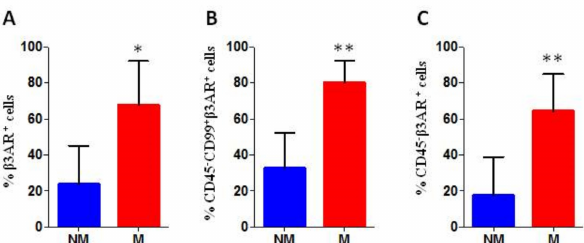
Figure 5. Cytofluorimetric analysis of biopsies derived cells, the percentage of positive cells is reported. ( A ) percentage of β 3-AR positive cells within all cells derived from the biopsy (% β 3-AR + cells range: NM 6–44%; M 43–87%); ( B ) percentage of β 3-AR positive cells within CD99 + gated cancer cells (% β 3-AR + cells range: NM 18–53%; M 63–86%); and ( C ) percentage of β 3-AR positive cells within CD45 − gated cells (% β 3-AR + cells range: NM 4–39%; M 43–84%). Biopsy samples from 7 patients: 4 M and 3 NM. p values for analysis: * p < 0.05 and ** p <